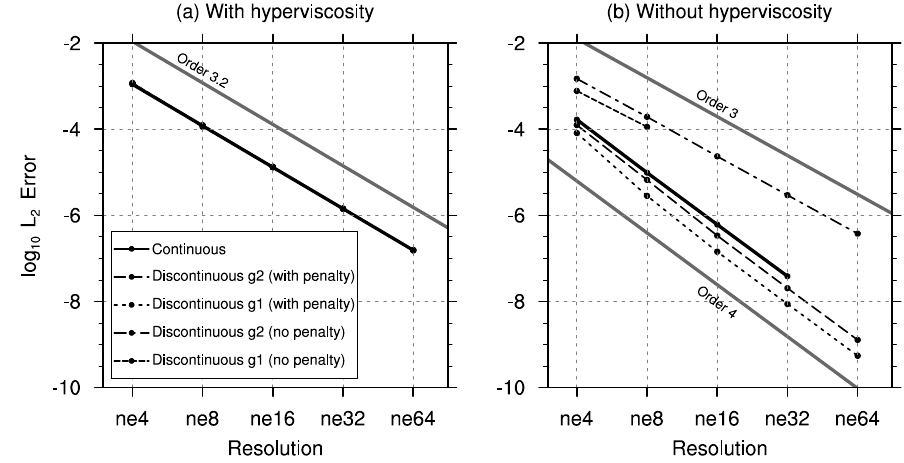
Figure 5. L 2 errors for geostrophically balanced flow on the cubed sphere at various resolutions with n p = 4 over a 5-day integration period. In (a) errors due to hyperviscosity dominate and so all simulations have approximately equal error leading to coincident lines. In (b) unstable simulations have been removed.